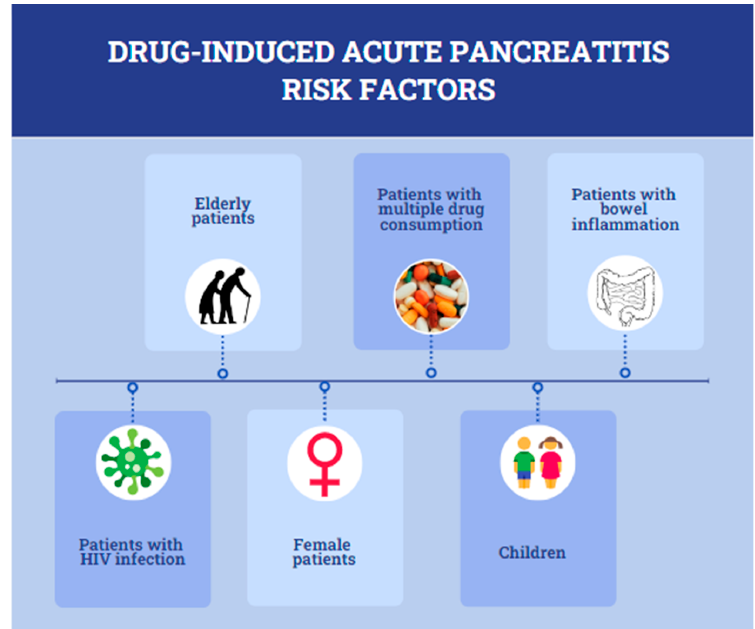
Figure 4. Drug-induced acute pancreatitis risk